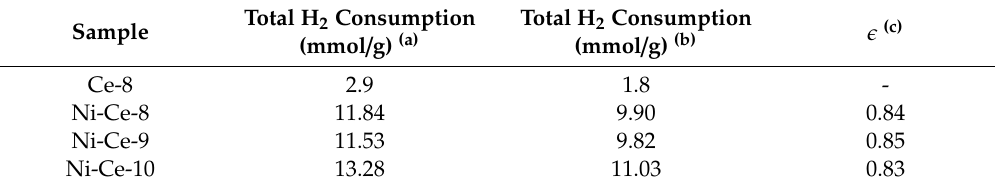
Figure 4. H 2 temperature-programmed reduction (H 2 -TPR) profiles of Ni-Ce-pH catalysts after calcination at 600 °C: ( a ) Ce-8; ( b ) Ni-Ce-8; ( c ) Ni-Ce-9; and ( d ) Ni-Ce-10. Table 4. H 2 uptake in the H 2 -TPR analysis of the prepared catalysts.